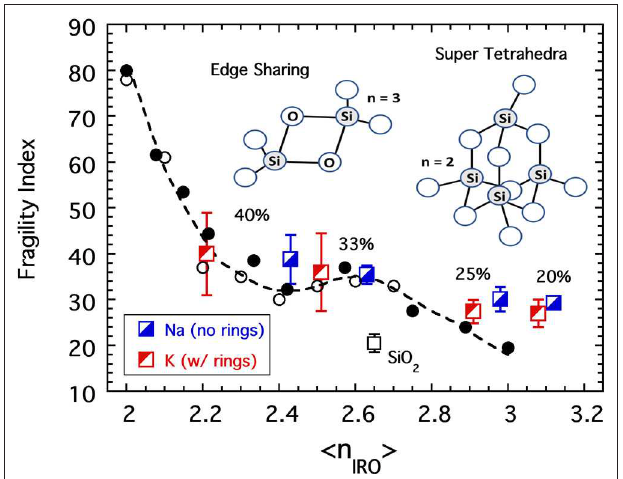
FIGURE 10 | The fragility indices of SiO 2 and selected sodium and potassium silicate glasses ( Poole, 1949; Nascimento and Aparicio, 2007; Nemilov, 2007) plotted as a function of the connectivity coarse-grained to include IRO structures as described in the text. Also shown are the data from Figure 4 for both the chalcogenides (plotted as a function of the average bond per atom) and the alkali phosphates (plotted as a function of the average BO per phosphate). Cartoons illustrate two of the structures, edge-sharing tetrahedra and a super-tetrahedron unit, reported ( Kalampounias et al., 2006a) to be present in silicate